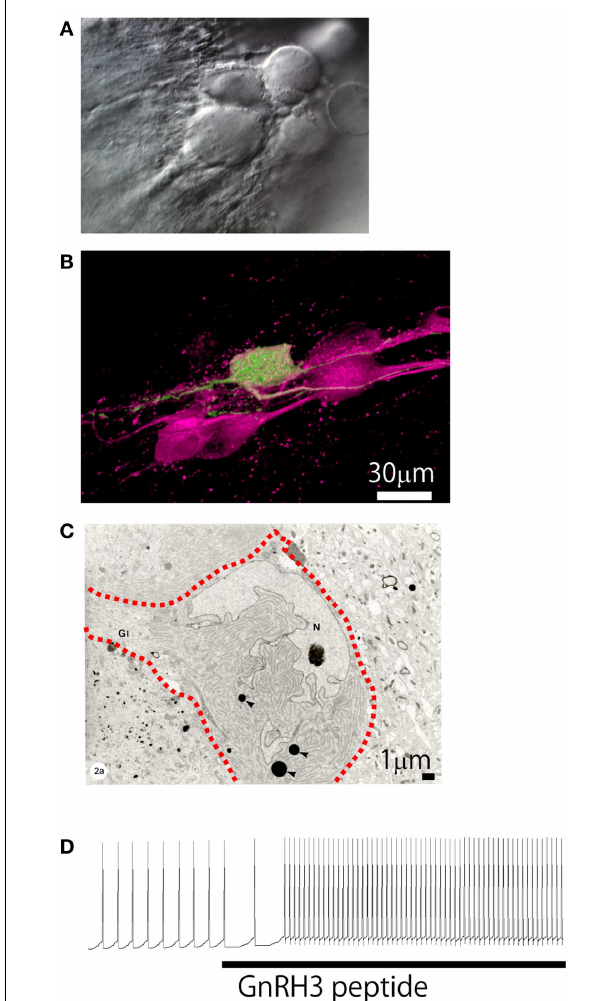
FIGURE 4 | Morphological and electrophysiological evidence for autocrine/paracrine regulation mechanism . (A) Differential interference contrast micrograph of the cluster ofTN-GnRH3 neurons. (B) Confocal micrograph of the cell cluster double-labeled for anti-sGnRH antiserum (magenta) and an intracellularly biocytin-labeledTN-GnRH neurons (green). Photo by Dr. H. Abe. (C) Electron micrograph of the cell cluster (three neurons; the interrupted red line indicates the cell border). (D) Electrophysiological recording showing upregulation of the pacemaker activity by the bath-applied